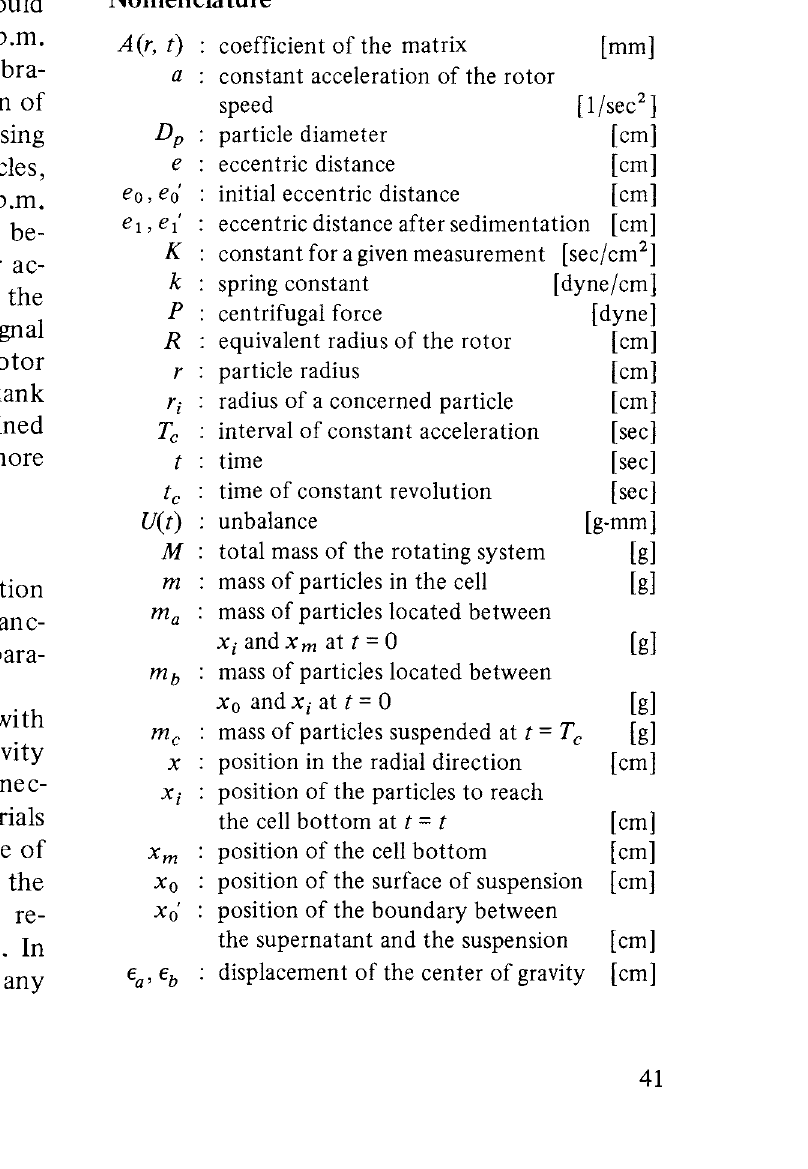
Fig. 11 Comparison of the measuring conditions measure in the coarser particle size range, Kanto loam was employed as substitute ma terial to compare with. The rotation speed was set at 1300 r.p.m. in this case, because the Kanto loam was relatively coarse and would have settled out immediately at 2500